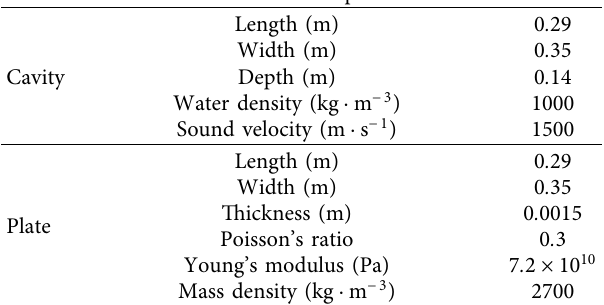
Table 1: The model